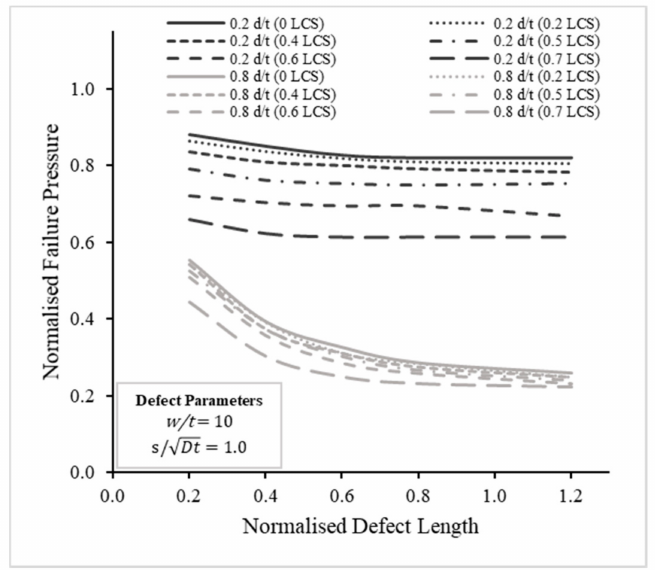
Figure 12. Comparison of normalised failure pressure predictions versus normalised longitudinal defect spacing across different longitudinal compressive stresses for defect depths of 0.2 and 0.8.